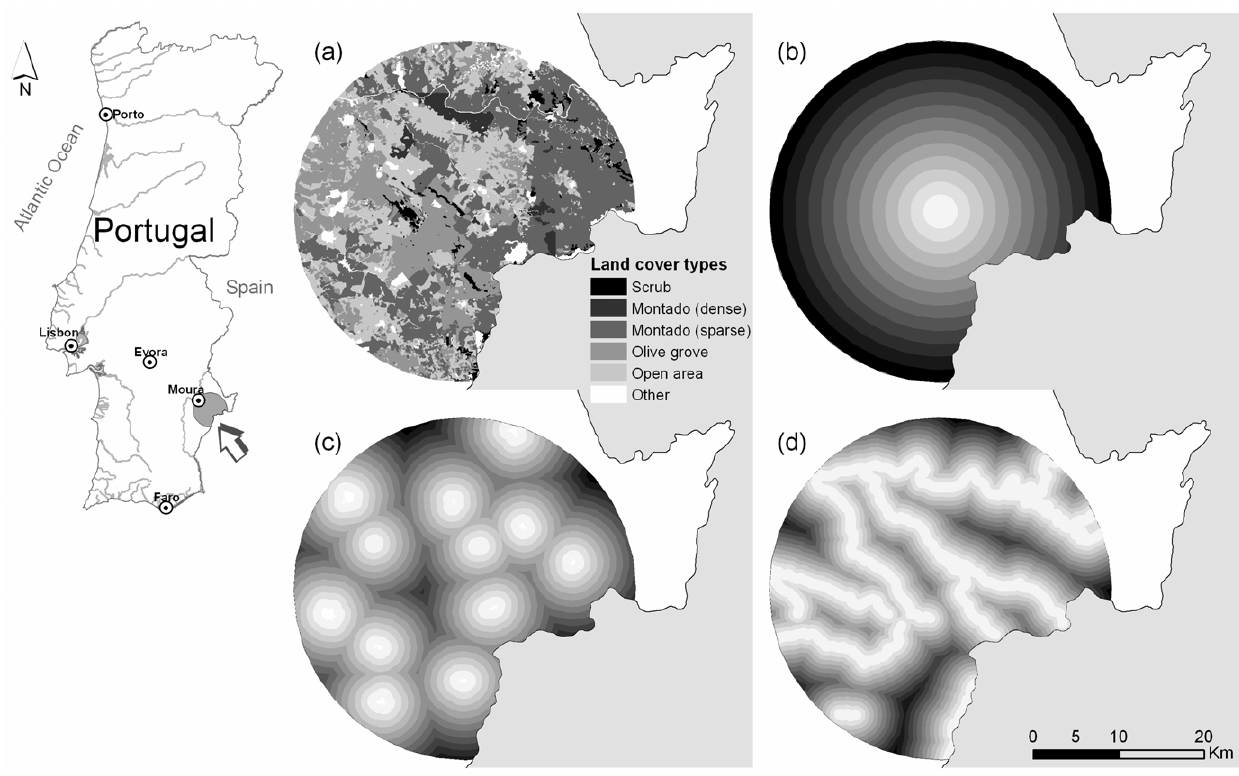
Figure 5. Location of the study area and representation of a subset of the variables analyzed. Variables: land-cover (a), distance to roost (b), distance to urban areas (c) and distance to water (d). Darker shades represent higher distances, in the last three variables.